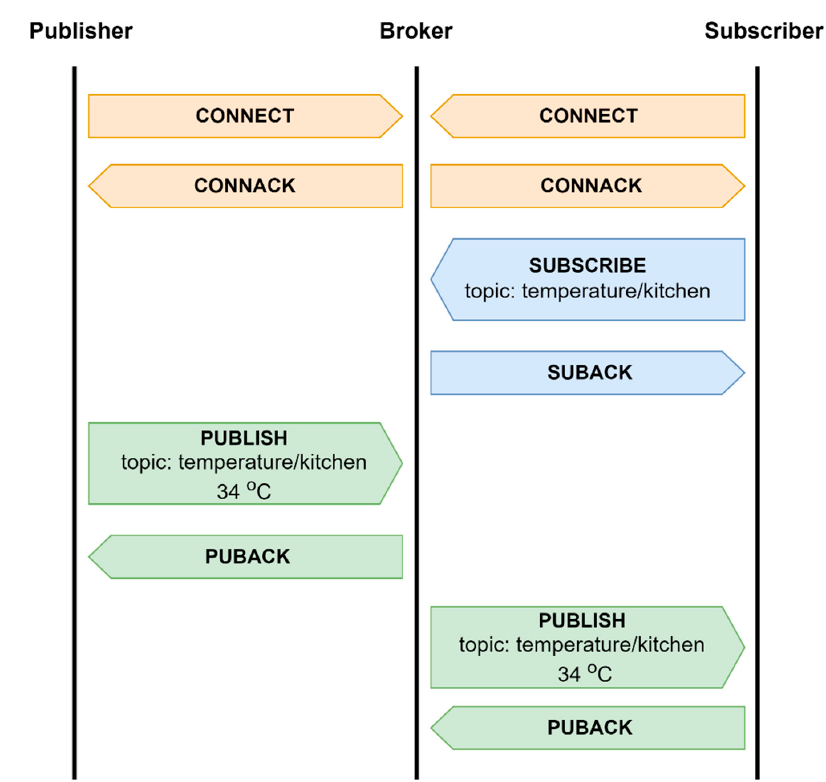
Figure 1. MQTT communication protocol (QoS